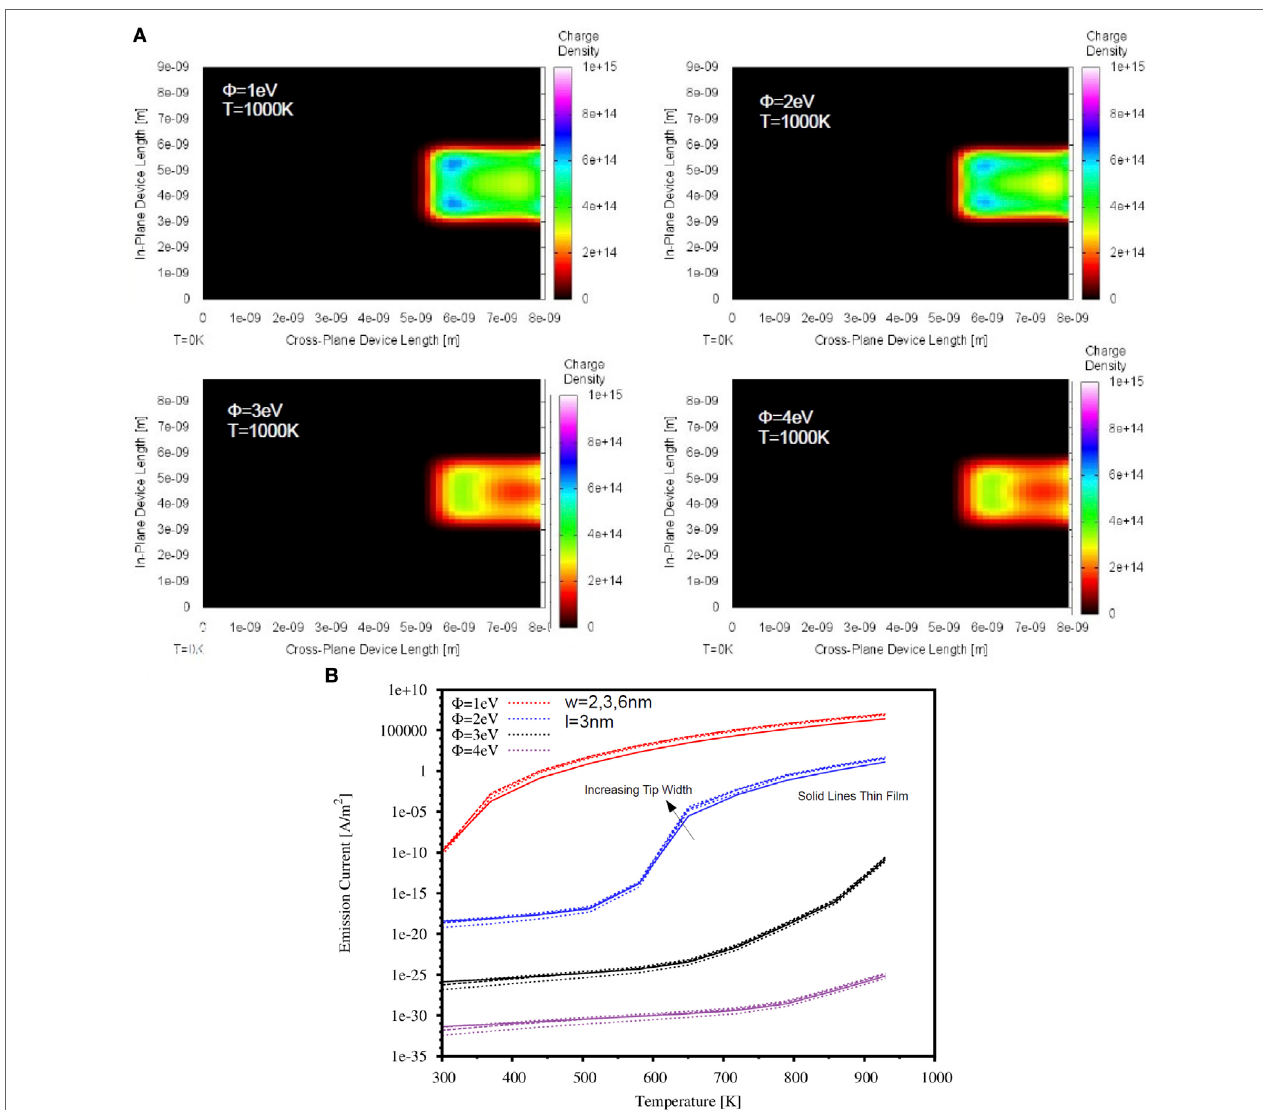
FigURe 4 | A non-equilibrium Green’s function model was used to investigate emission current as a function of tip length and width. (A) The calculated local density of states for several work function materials. (B) The lower plot is the emission current for a series of tip widths. Dashed lines include a tip, and solid lines are thin-film results. Images provided courtesy of T.